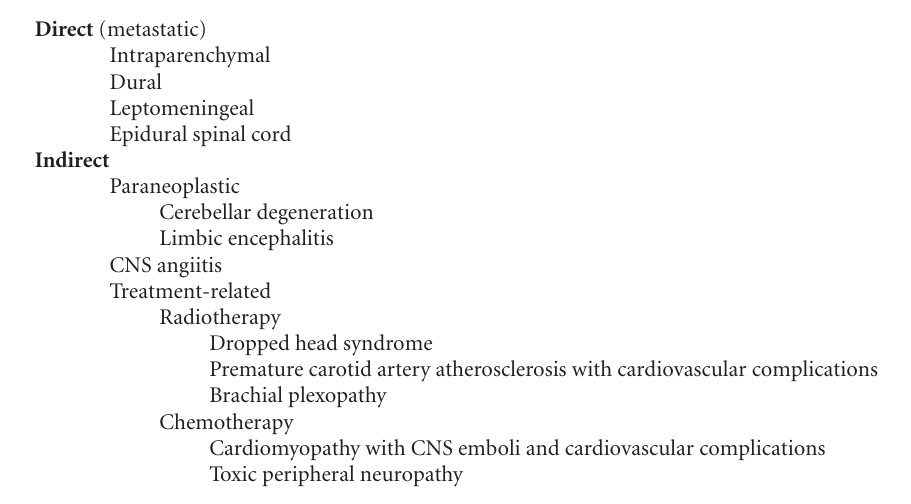
Algorithm 1: Neurological complications of Hodgkin’s